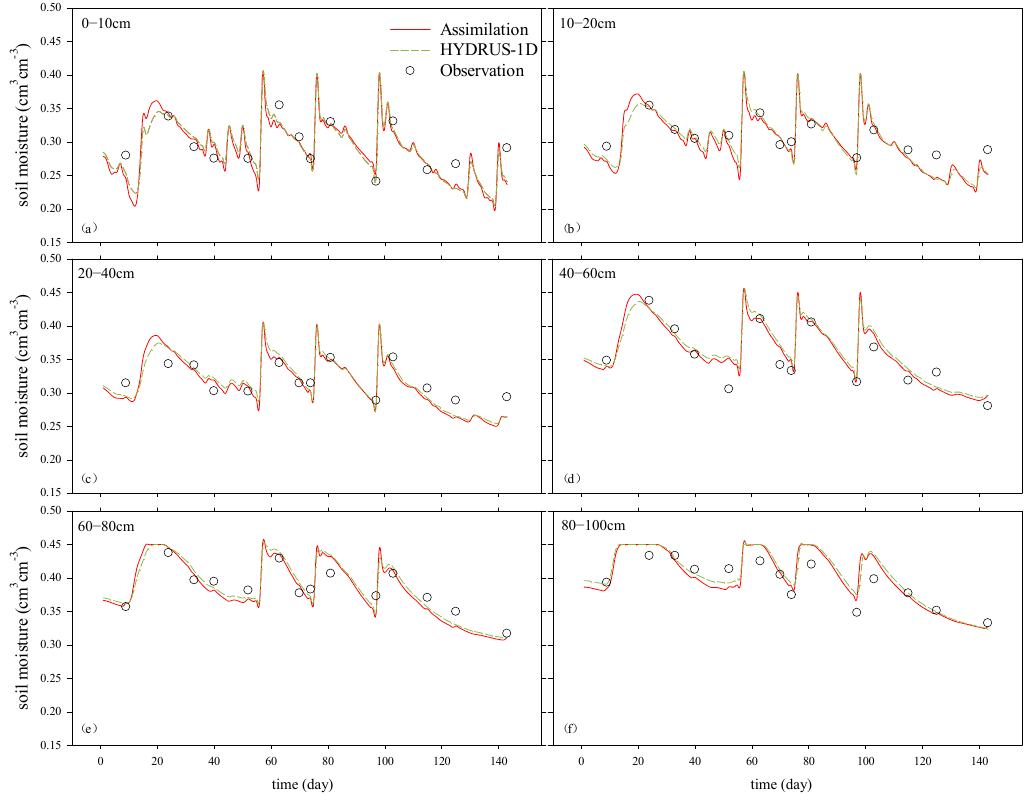
Figure 5. Simulated soil moisture at different depths with assimilation of the soil moisture and salinity. (Green dashed lines represent the simulated results from Ren et al. [34] obtained using HYDRUS-1D; red solid lines represent the assimilation results).